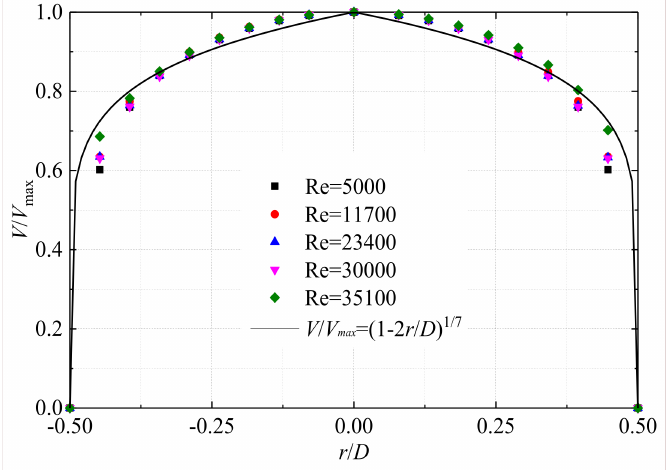
Figure 7. Radial distribution of dimensionless velocity V/V max under different Reynolds